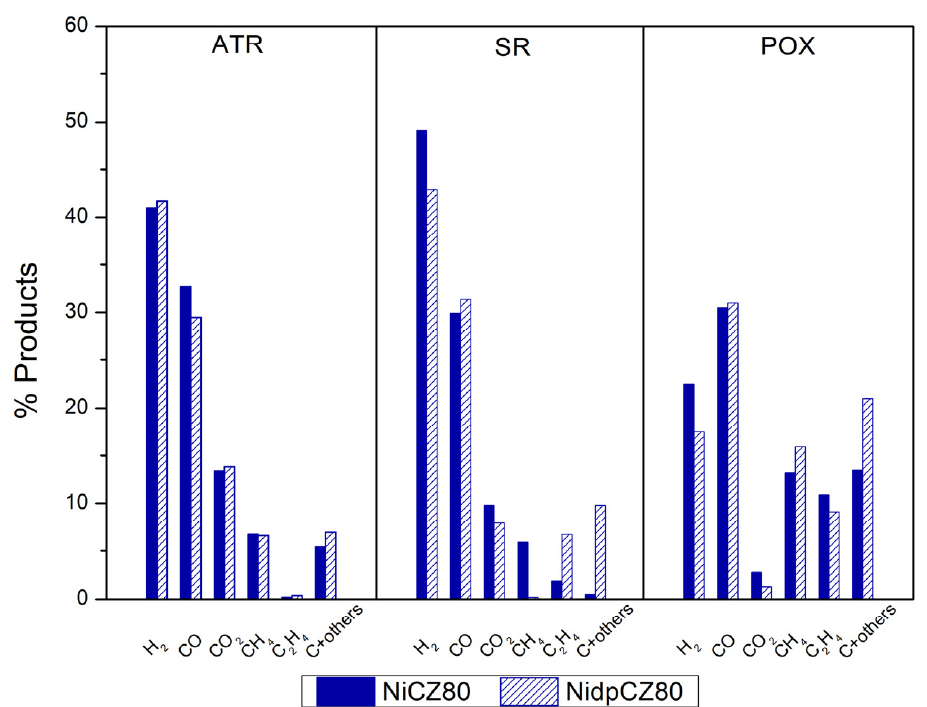
Figure 10. Product distribution for NiCZ80 and NidpCZ80 under ATR, SR and POX conditions of methane at T = 800 °C, GSVH = 120,000 h − 1 .